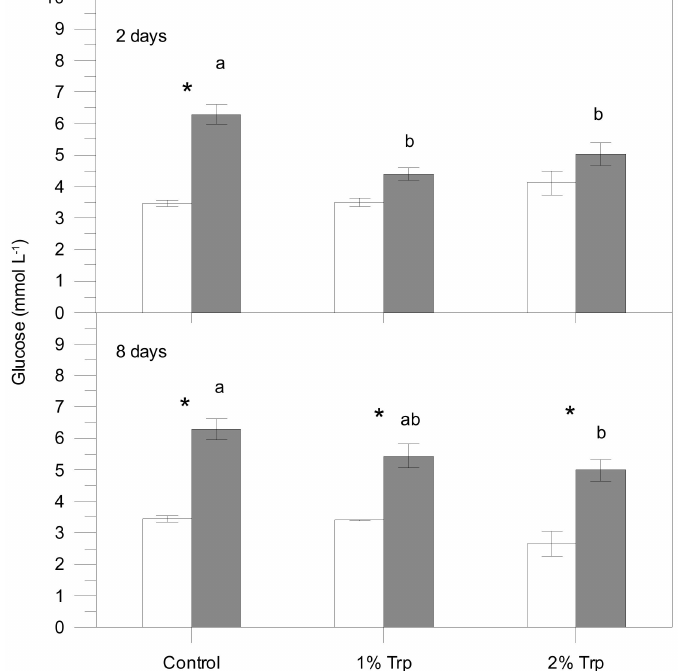
Figure 2. Plasma glucose concentration for each treatment (mean ± SE). White and grey bars are pre- and post-stress values, respectively. White and grey bars are pre- and post-stress values, respectively. Asterisks indicate significant di ff erences between pre- and post-stress conditions. Di ff erent letters indicate significant di ff erences among groups (di ff erent experimental feeds) within each sample (pre- and